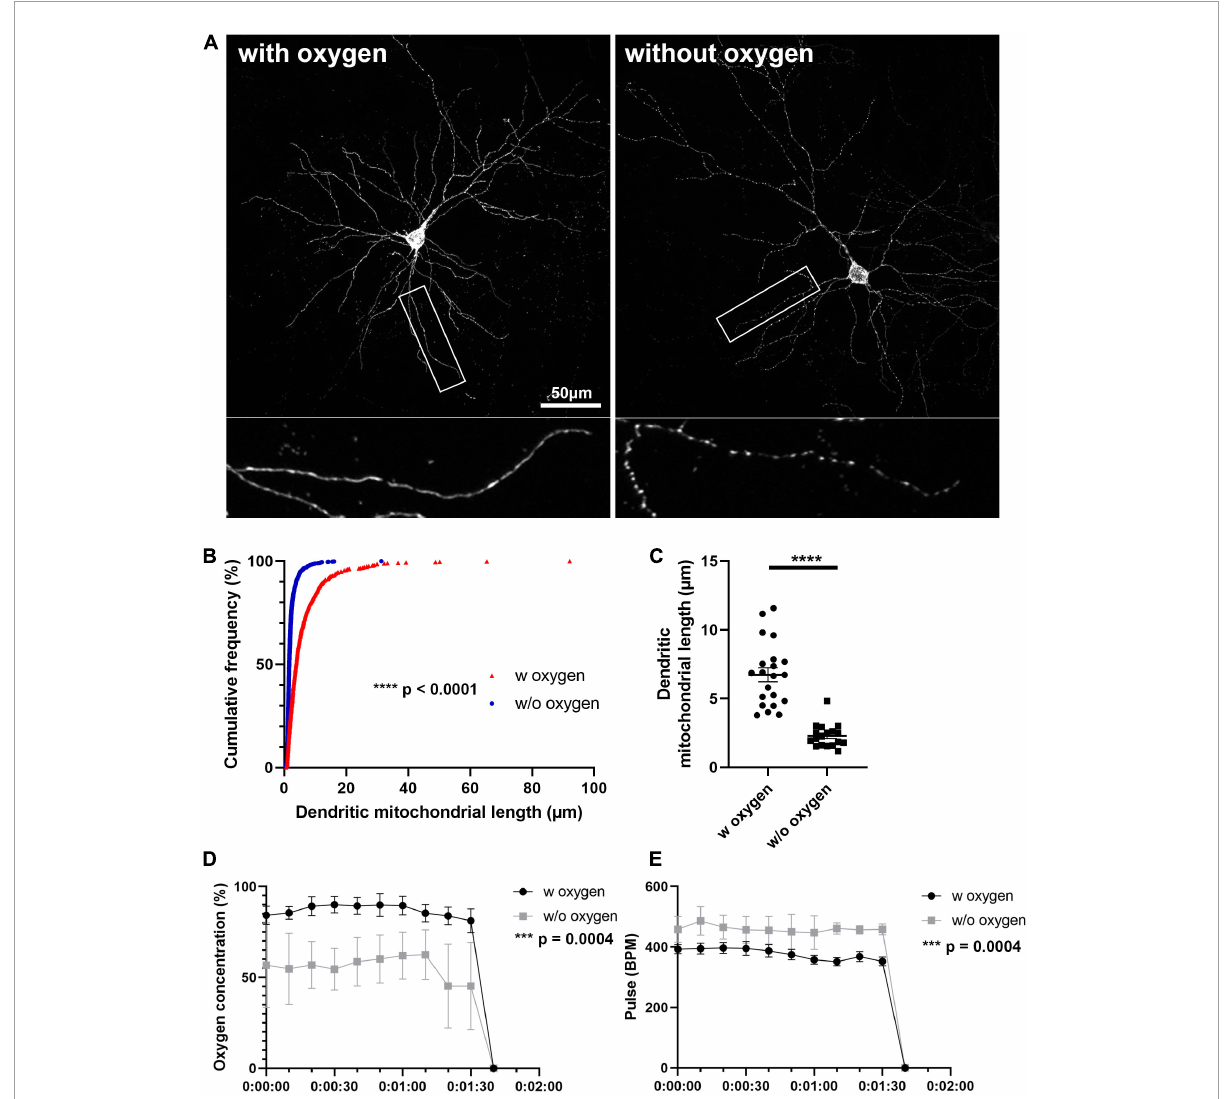
FIGURE3 Oxygen supply is necessary for preserving mitochondrial morphology during anesthesia and perfusion. (A) Representative images of mitochondria after perfusion. (B) Cumulative frequencies of dendritic mitochondrial length showing that perfusion without oxygen supplement results in fragmentation of mitochondria. n with oxygen = 627 mitochondria and n without oxygen = 1061 mitochondria. Kolmogorov–Smirnov test, **** p < 0.001. (C) Quantification of dendritic mitochondria in each perfusion condition confirmed shorter mitochondria in perfusion without oxygen compared to perfusion with oxygen. n with oxygen = 42 dendrites and n without oxygen = 36 dendrites. Unpaired t -test, **** p < 0.0001. (D,E) Oxygen concentration and pulse were measured during perfusion procedure. n with oxygen = 7 mice and n without oxygen = 6 mice. Mann–Whitney test, *** p = 0.0004. Scale bar, 50 µ